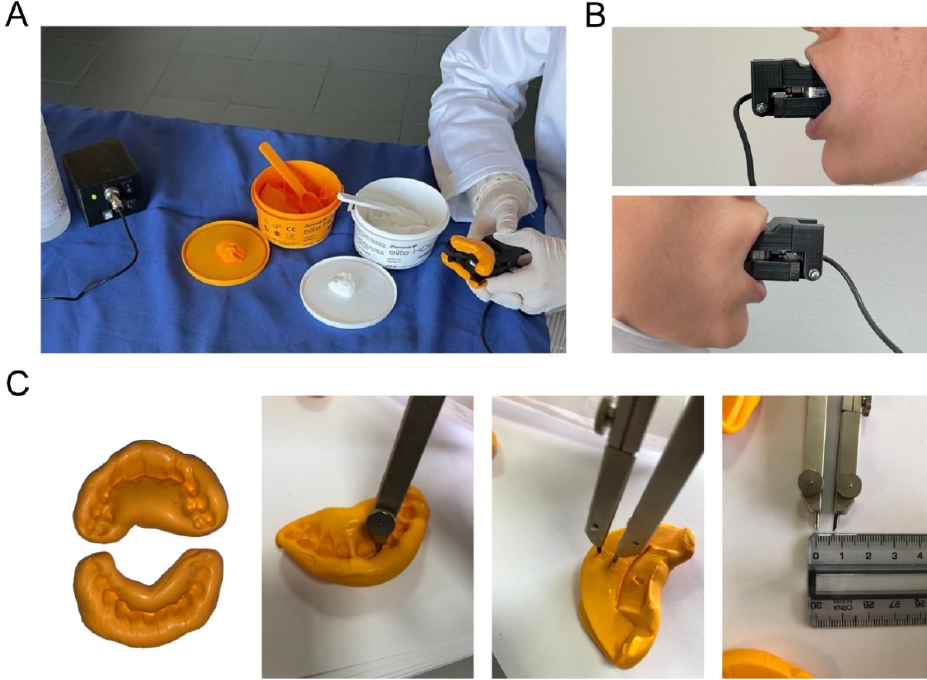
Figure 6. Experimental procedure. ( A ) Device setup steps. During setup phase, therapist places the teeth silicone molds on the device forks. ( B ) Device placed in subject’s mouth. ( C ) Example of the subject’s customized upper and lower silicone molds and the application point distance measurement phase. During this phase, the distances between both incisors, upper and lower, and the center of the sensor are estimated thanks to the notches on the silicone mold.